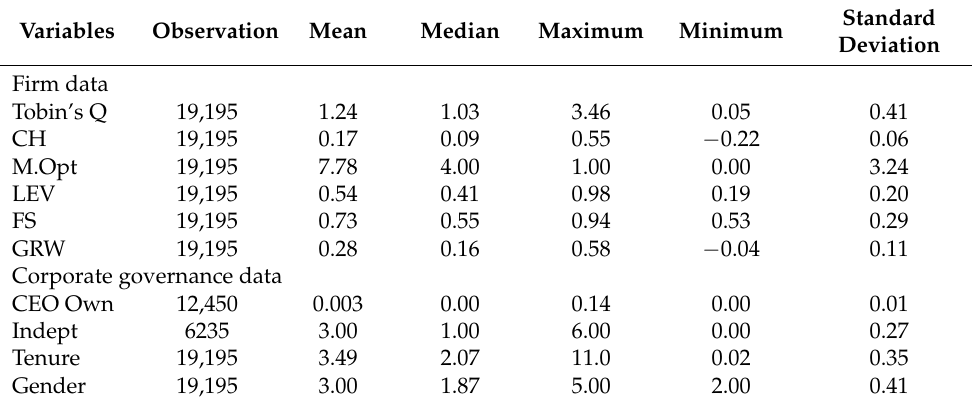
Table 4. Descriptive statistics of the whole